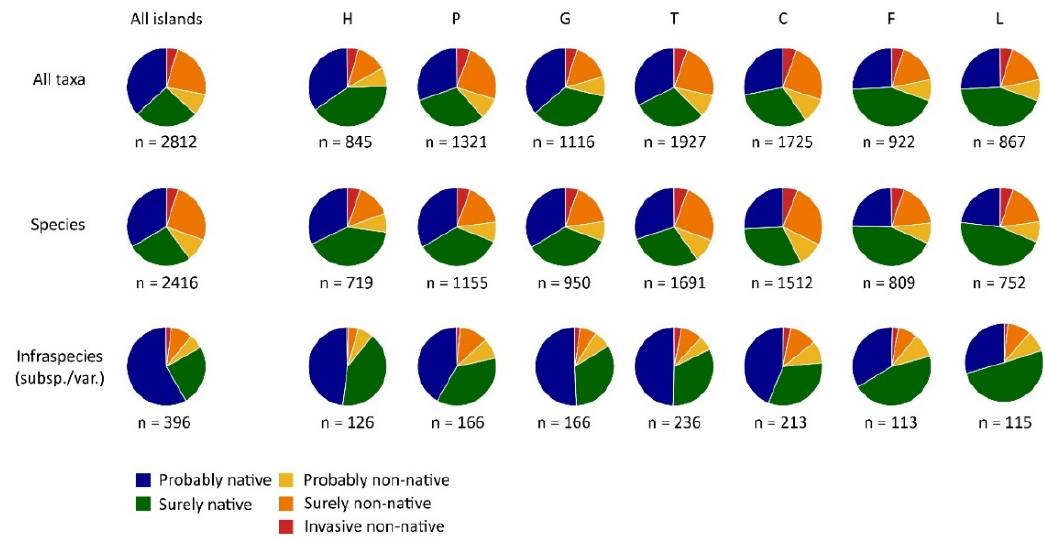
Figure 2. Categories of native and non-native taxa in the Canary Islands and for the individual islands El Hierro (H), La Palma (P), La Gomera (G), Tenerife (T), Gran Canaria (C), Fuerteventura (F) and Lanzarote (L) based on the here presented checklist. Proportions are given at the level of all taxa, and separately for species and infra specific taxa (sub-species and varieties). Absolute numbers of taxa are given below the pie charts. Generally, the proportion of accepted native infraspecific units (subspecies, varieties) is higher compared with the accepted species. Highest numbers of taxa are listed for the large islands with pronounced topography and diverse climatic